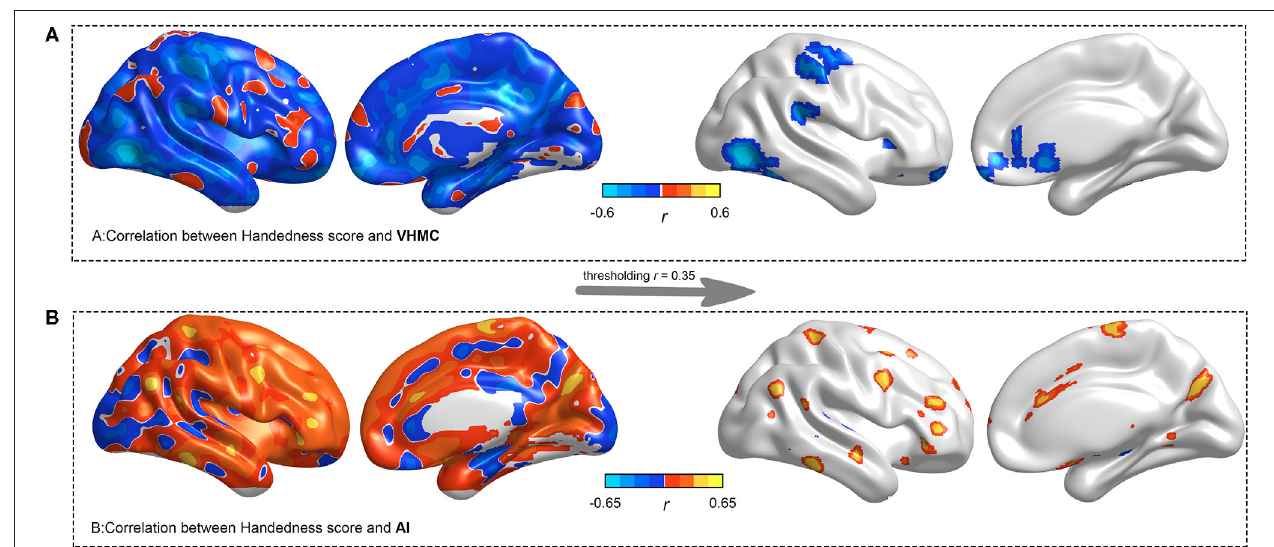
FIGURE 3 | Voxel-wise whole-brain linear regression analysis between VMHC/AI and handedness scores. The statistical significance was voxel p < 0.005 and corrected at FWE cluster p < 0.050. The left panel indicates unthresholded voxel-wise correlation coefficients, and the right panel indicates thresholded ( r = 0.35) voxel-wise correlation